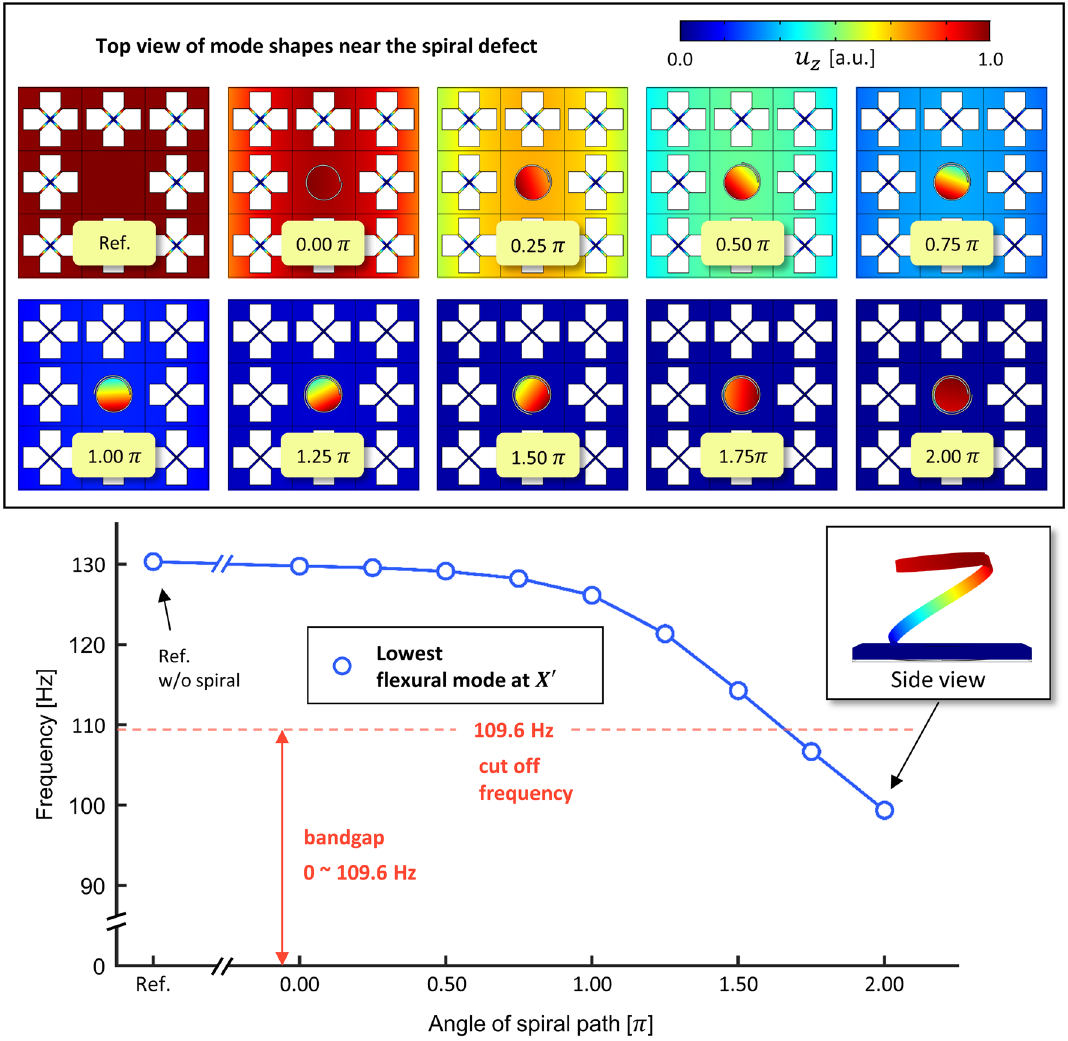
Figure 8. Frequency of the lowest flexural mode at X ′ as the angle of the spiral path